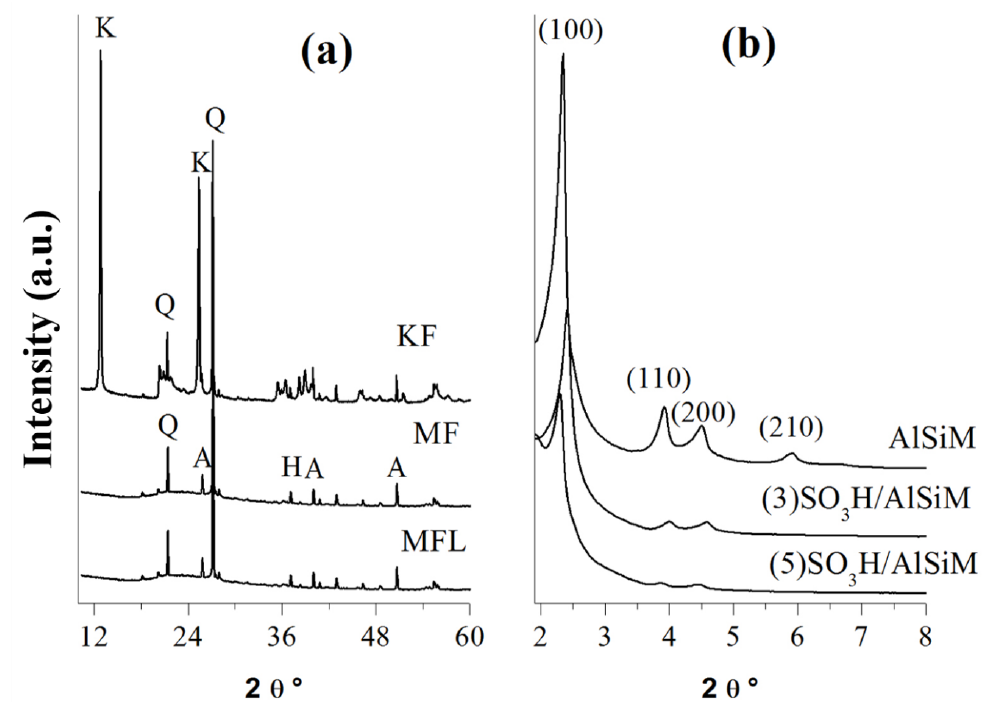
Figure 1. X-ray diffraction patterns: ( a ) flint kaolin (KF), metakaolin flint (MF), metakaolin flint leached (MFL), K = kaolinite, Q = quartz, A = anatase, H = hematite. and ( b ) aluminosilicates calcined (AlSiM) and functionalized with sulfonic group,(3)SO 3 H/AlSiM and (5)SO 3 H/AlSiM).